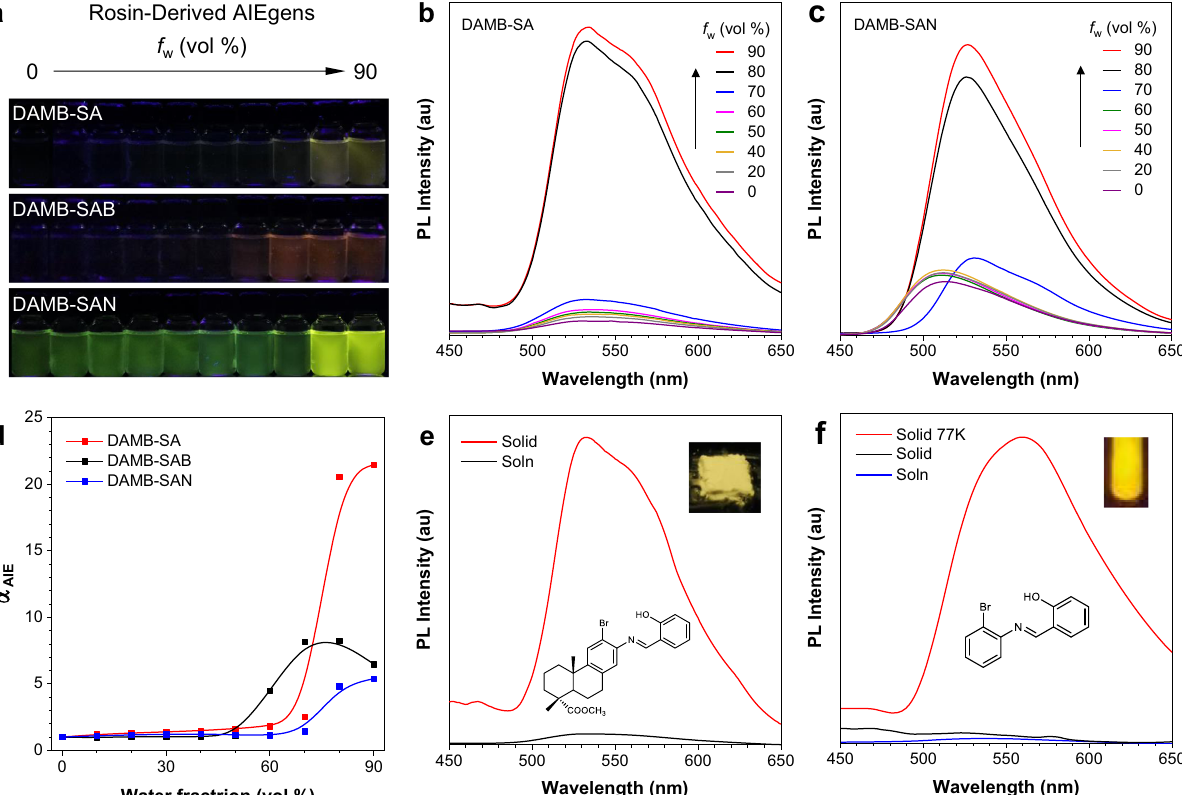
Fig. 2 Aggregation-induced emission properties. a Fluorescence photographs of DAMB-SA, DAMB-SAB, and DAMB-SAN in ACN/H 2 O mixtures with different water fractions ( f w ) taken under 365 nm UV irradiation. Concentration: 20 µ M. b , c PL spectra of DAMB-SA ( b ) and DAMB-SAN ( c ) in ACN/H 2 O mixtures with different f w . Concentration: 20 μ M; λ ex : 350 nm. d The plots of the α AIE versus the composition of the aqueous mixture of DAMB-SA, DAMB- SAB, and DAMN-SAN. α AIE = I / I 0 , I 0 = PL intensity in pure ACN. e PL spectra of DAMB-SA in dilute ACN solution (20 μ M) and as solid at room temperature, respectively. f PL spectra of AB-SA in dilute ACN solution (20 μ M) and as solid at room temperature and 77 K, respectively. λ ex : 350 nm. Inset: fl uorescence photographs of DAMB-SA (room temperature) and AB-SA (77 K) taken under 365 nm UV irradiation. Concentration: 20 µ